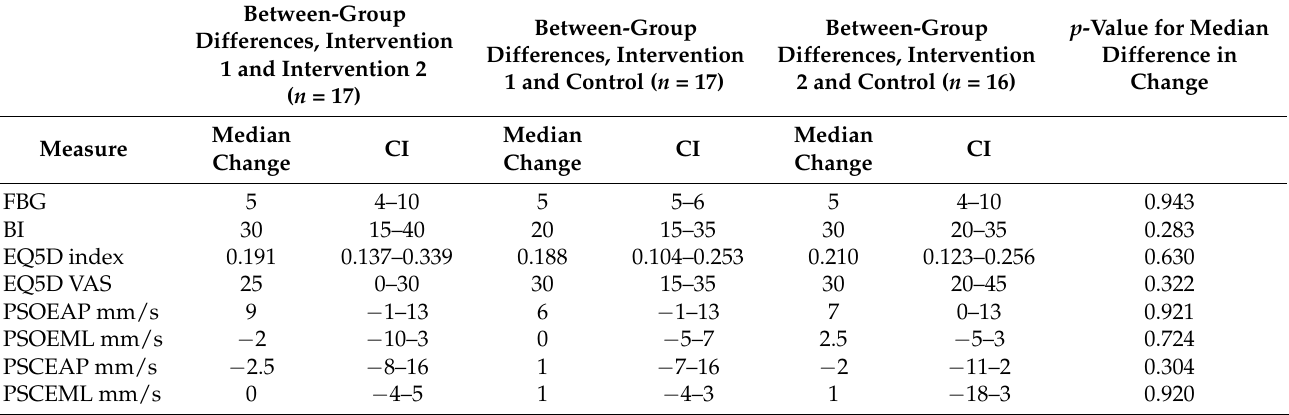
Table 5. On-treatment analysis of differences in changes between baseline and follow-up between groups. Median change and CI between intervention 1 and intervention 2, intervention 1 and control, and intervention 2 and